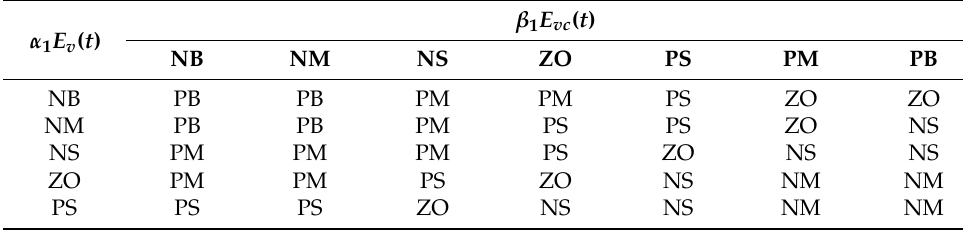
Table 2. Fuzzy rule of λ 1 ∆ K p ( t